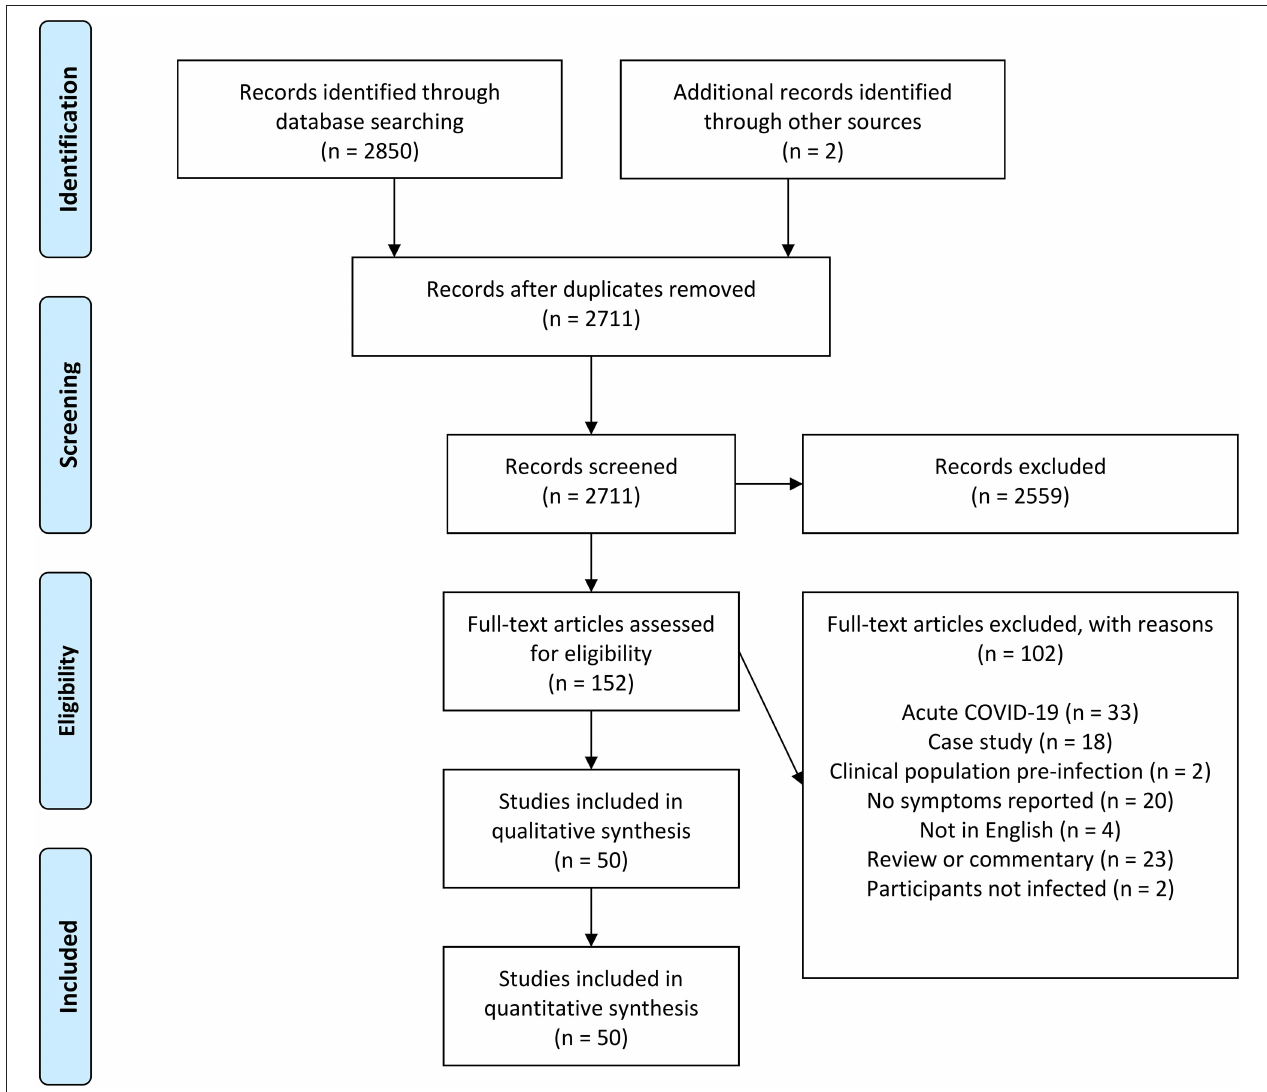
FIGURE 1 | Schematic flow diagram describing exclusions of potential studies and final number of